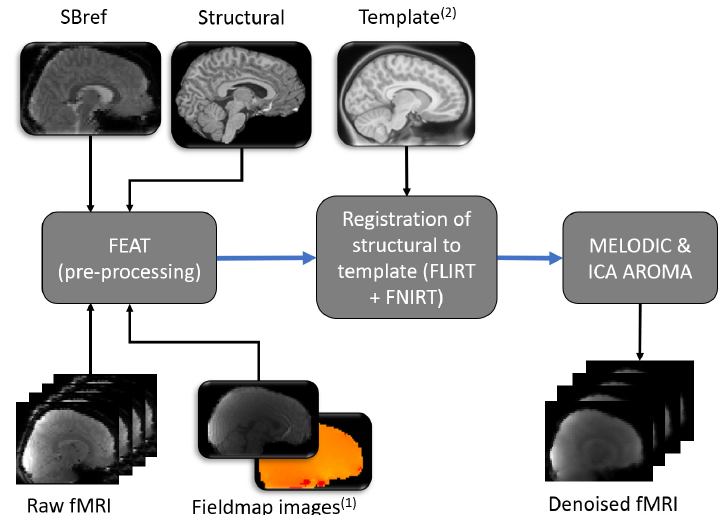
Figure 2. Graphical representation of functional MRI analysis pipeline. Images from one participant represent examples of input and output data files. Blue arrows denote pre-processing steps using freely available online tools (named within dark grey boxes). Pictures with round corners represent 3 dimensional images, while a series of pictures represents 4 dimensional functional data. FEAT was run using the graphical user interface (rather than by running a script), therefore additional required options are detailed within the main text. Subscript numbers highlight steps that were modified in relation to a typical adult pipeline (see Figure 3 for (1) and Figure 4 for